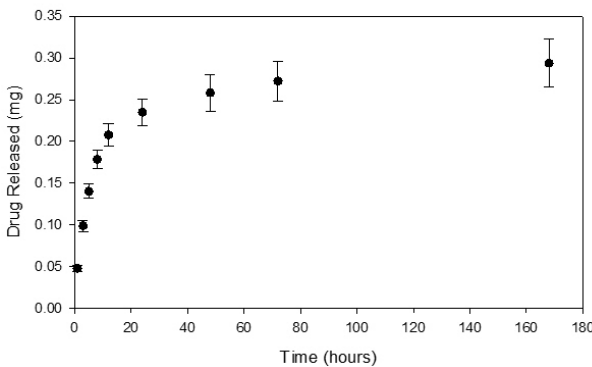
Figure 8. Dexamethasone release curve from loaded poly(HEMA) nanoparticles prepared according to sample A3 in Table 1 released from 50 kDa MWCO dialysis tubing under sink conditions. Initial loading of dexamethasone was 15.0% (±1.4%). Error bars were determined from the standard error.